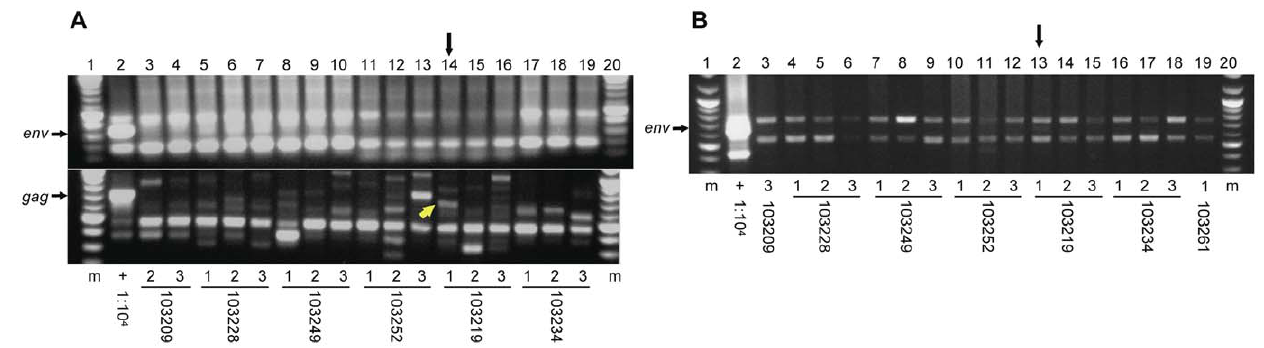
Figure 2. Screening for XMRV in patient PBMCs by PCR. PCR products were analyzed on agarose gels containing ethidium bromide. (A) Representative gels for non-nested env (top panel) and non-nested gag (bottom panel) PCRs are shown containing a set of three replicates for each of 5 HIV-1 + patient samples. A yellow arrow indicates the sole PCR band, from patient 103219, found to be comprised of XMRV DNA by sequencing. (B) A representative gel for nested env PCR is shown for the same 5 HIV-1 + patient samples depicted in (A). Vertical black arrows in (A) and (B) indicate lanes from patient 103219 containing either (A, bottom panel) a band comprised of XMRV sequence or (B) a band of the expected mobility for the target sequence. (m) 100 base pair molecular weight marker, (1:10 4 ) DNA from one infected cell diluted in DNA from 10 4 uninfected cells used as template for positive control.